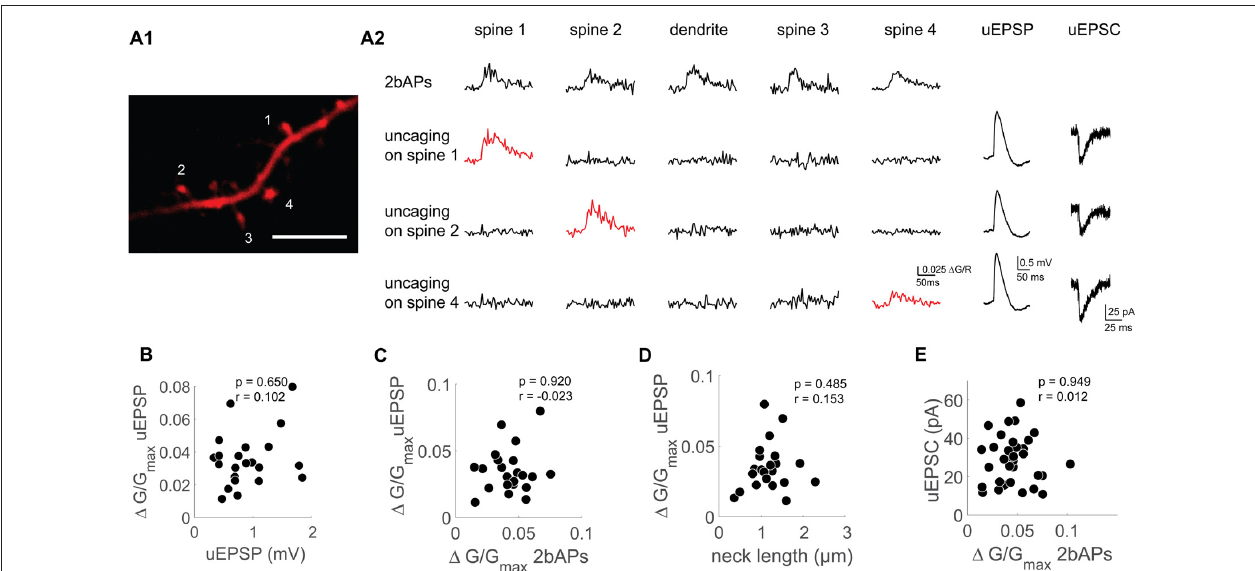
FIGURE 3 | Functional uncoupling between bAP Ca 2 + transients, uEPSP mediated Ca 2 + transients and AMPAR-mediated uEPSCs on the single spine level. (A1) Z-projection of the imaged dendritic segment. Scale bar: 2 µ m. (A2) Doublet evoked bAP-Ca 2 + transients (2bAPs), uncaging evoked Ca 2 + transients with corresponding uEPSPs and uEPSCs, spines are marked in (A1) . Doublet evoked bAP-Ca 2 + transients and uncaging evoked Ca 2 + transients were also recorded in the adjacent dendritic segment. (B) Scatter plot of uEPSPs vs. uncaging evoked Ca 2 + transients. Statistics: spearman correlation. (C) Scatter plot of doublet evoked Ca 2 + transients and uncaging evoked Ca 2 + transients. Statistics: spearman correlation. (D) Correlation of neck length and uncaging evoked Ca 2 + transients. Statistics: spearman correlation. (E) Correlation of doublet evoked Ca 2 + transients and uEPSCs. Statistics: spearman